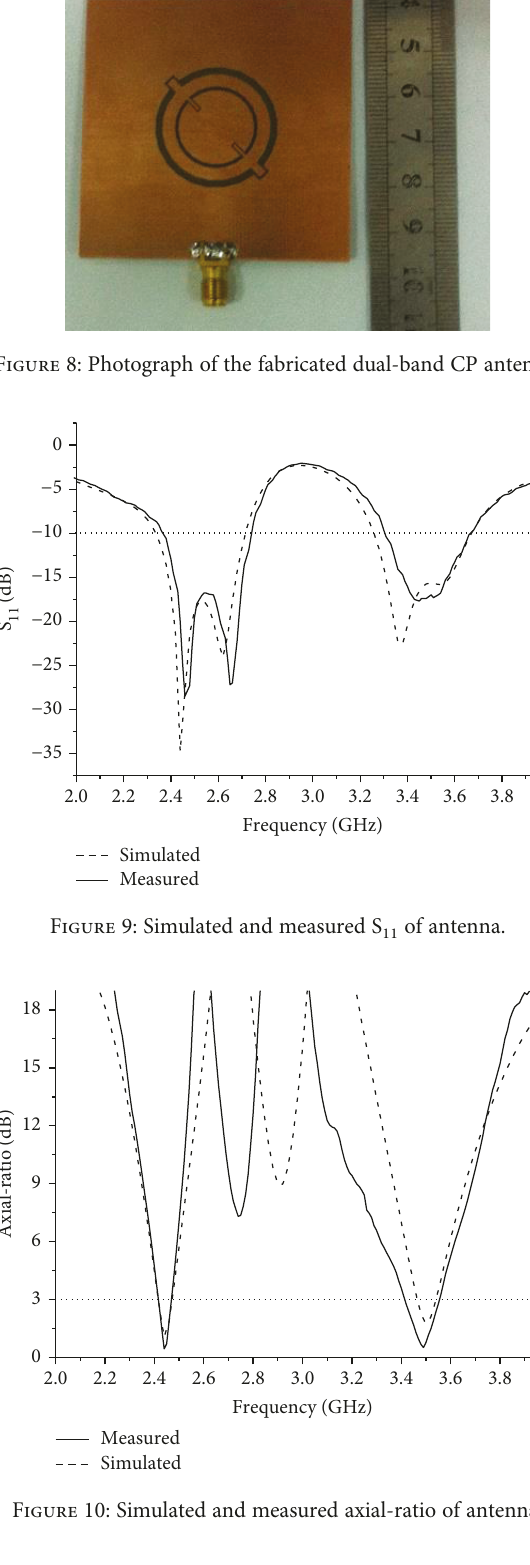
Figure 10: Simulated and measured axial-ratio of